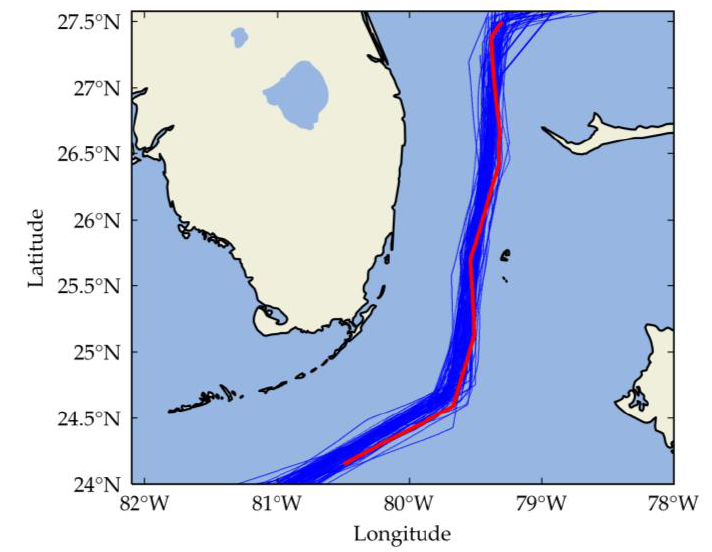
Figure 11. Trajectory of the target ship. The blue lines are the trajectories of other ships in the dataset, and the red line is the target ship’s